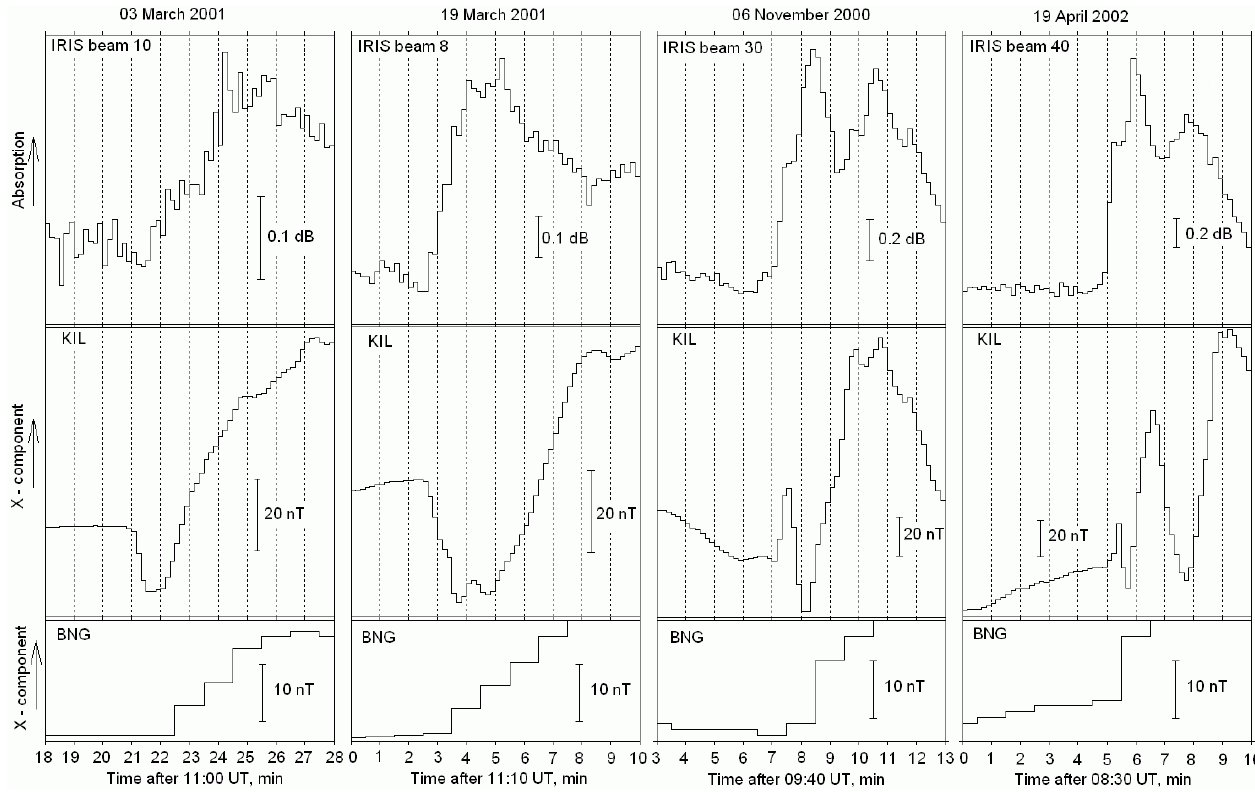
Fig. 7. Different shape of magnetic response to SWPP at high latitudes. Magnetic variation begins simultaneously with SCA event but forestalls the step-like disturbance at equatorial